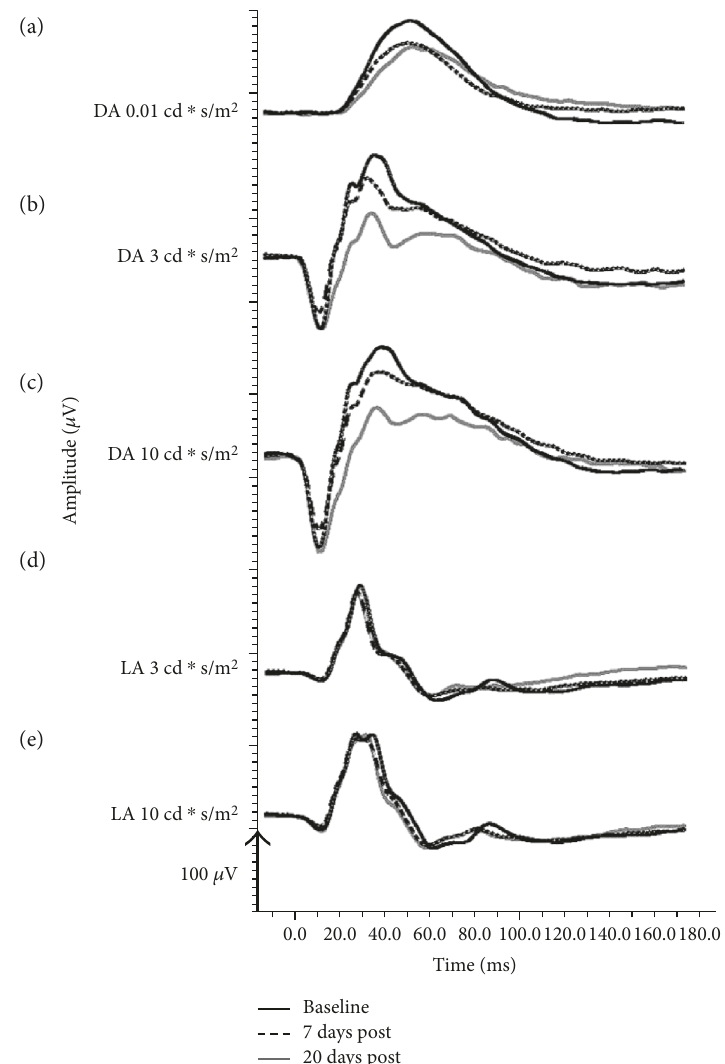
Figure 4: Representative traces in response to the fi ve transient fl ash stimulations, recorded from a single eye before 7 and 20 days postretinal detachment. Note the WDS attenuation in panels (b) and (c). DA =dark adapted, LA =light adapted, and RD =retinal